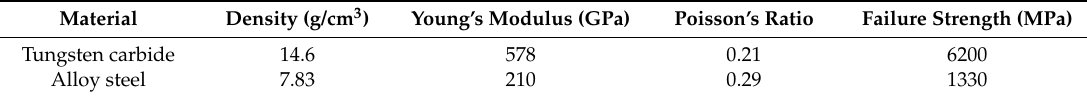
Table 1. Material parameters of tungsten carbide cylinder and alloy steel supporting rings.